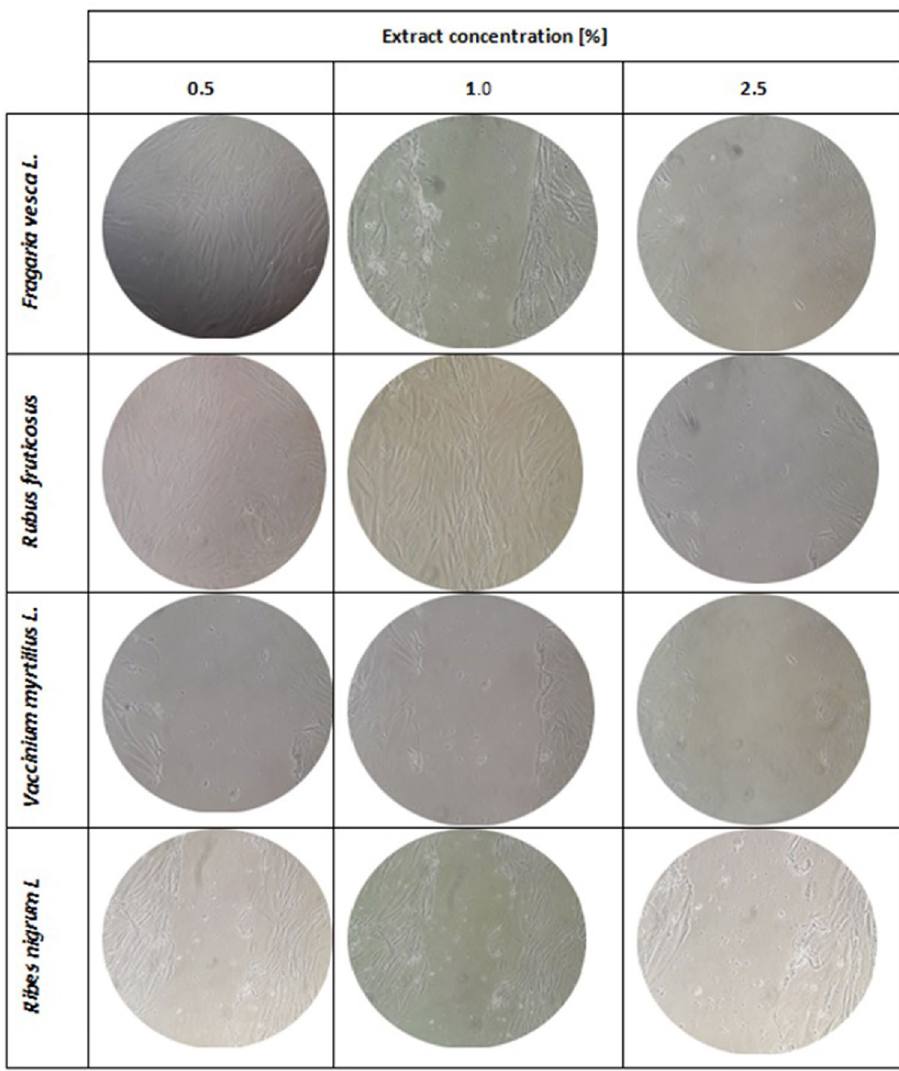
Figure 4. The effect of water-glycerin leaf extracts from Ribes nigrum L., Vaccinium myrtillus L, Rubus fruticosus L. and Fragaria vesca L. (at a concentration of 0.5–2.5%) on the migration of fibroblast cells after a